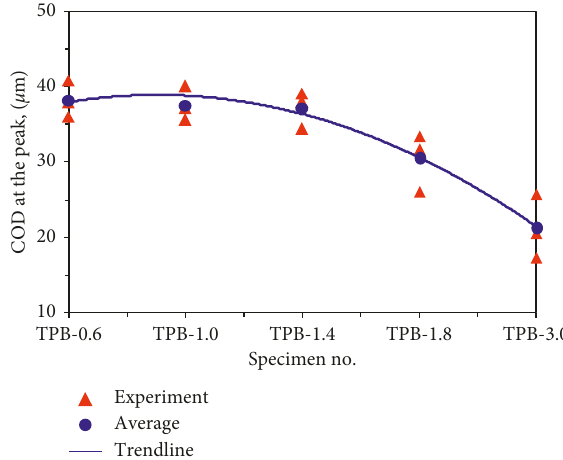
0mm in Figure 11 under (cid:30)